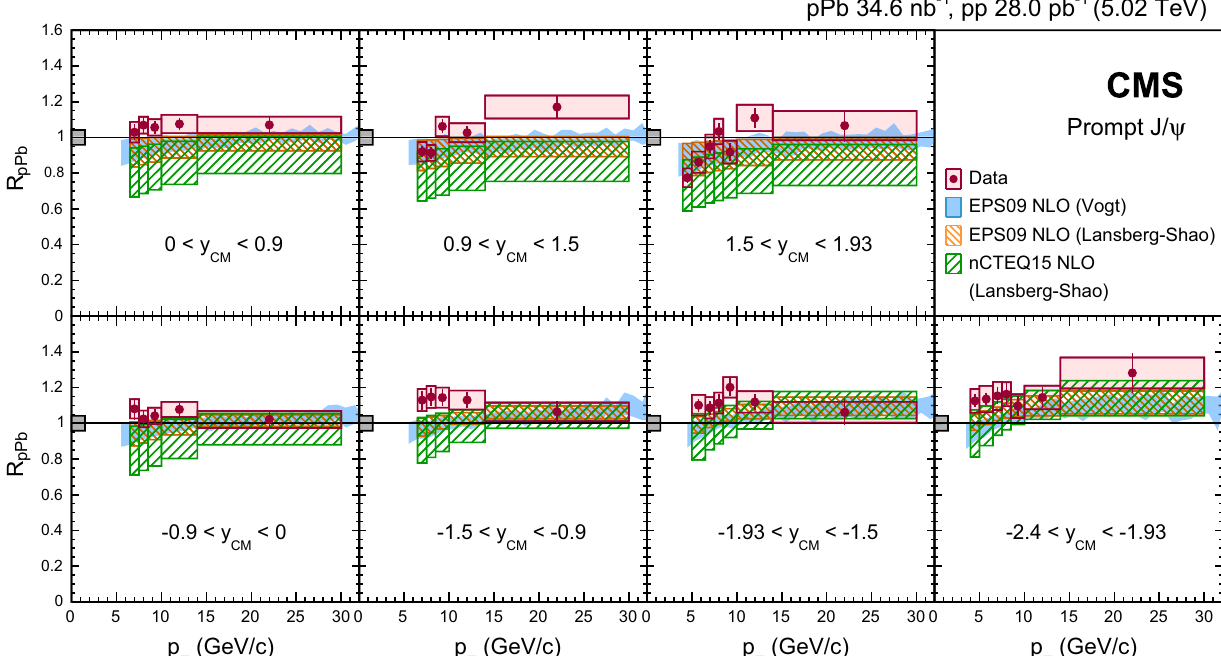
Fig. 4 Transverse momentum dependence of R pPb for prompt J /ψ mesons in seven y CM ranges. The vertical bars represent the statistical uncertainties and the shaded boxes show the systematic uncertainties. The fully correlated global uncertainty of 4.2% is displayed as a gray